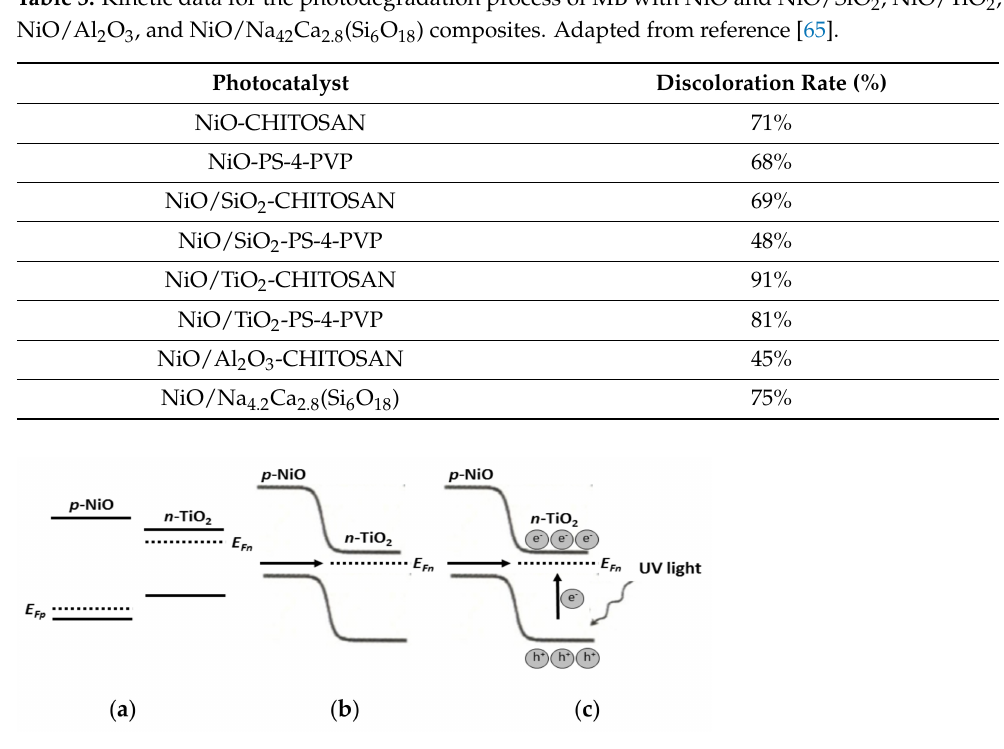
Table 3. Kinetic data for the photodegradation process of MB with NiO and NiO/SiO 2 , NiO/TiO 2 ,